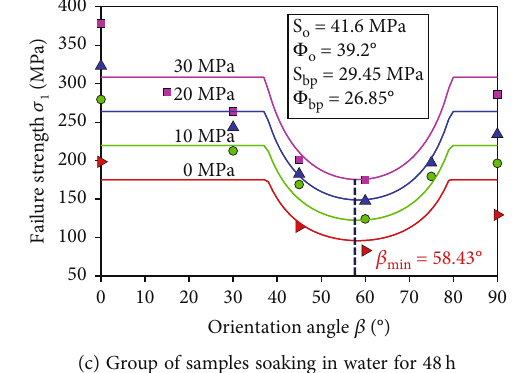
(b) Group of samples soaking in water for 24 h